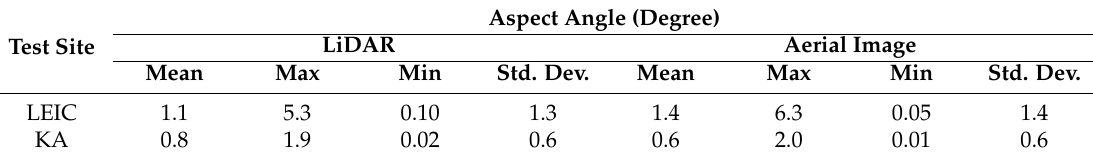
Table 6. Differences between the aspect angle of the extracted roof planes and their corresponding reference planes for both data types and test sites (Leicester = LEIC, Karlsruhe = KA).